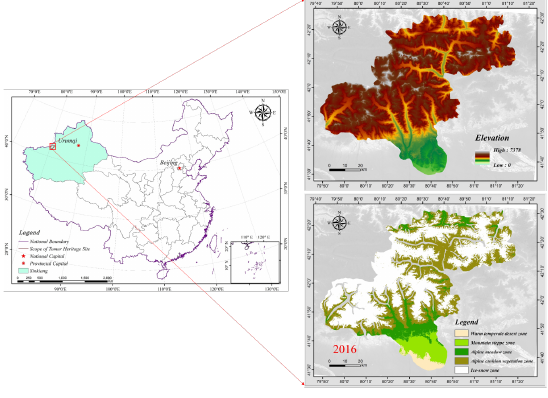
Figure 1. Location and scope of the study